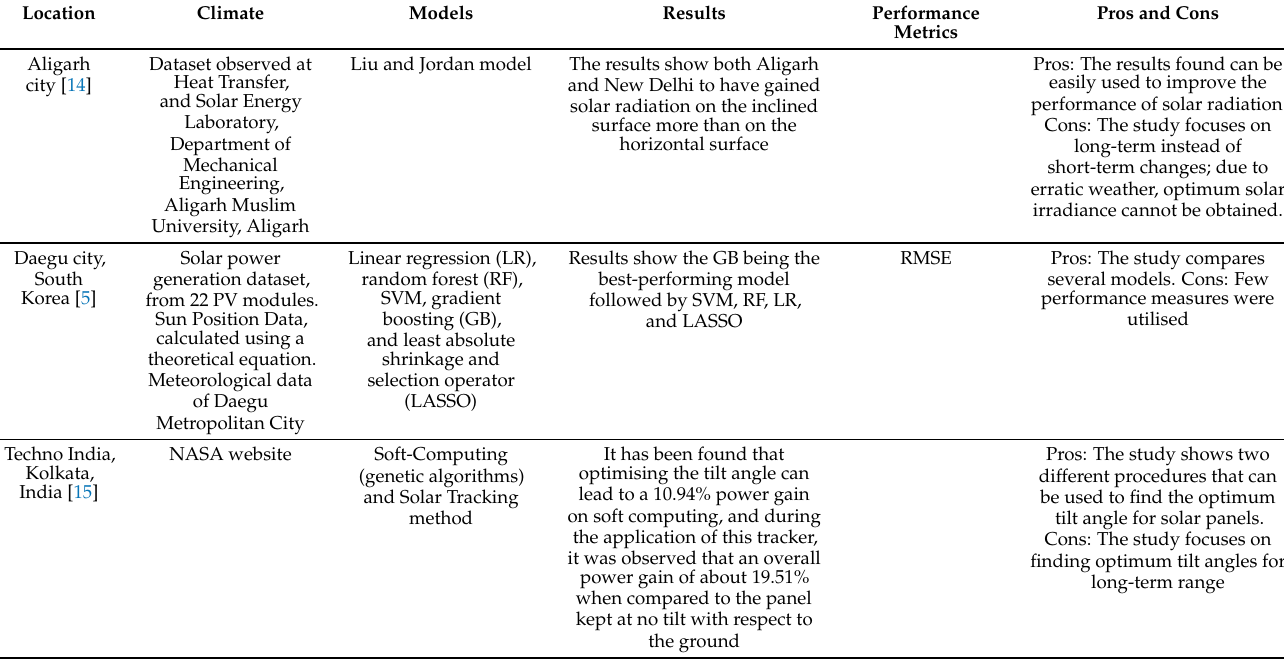
Table 1. Summary of some of the related